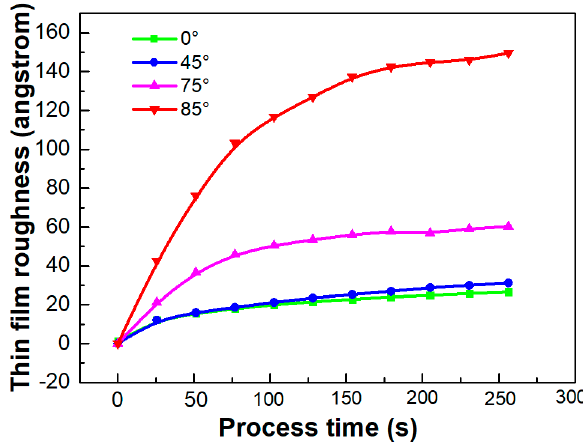
Figure 10. Simulated nanostructure thin film under different deposition angles.